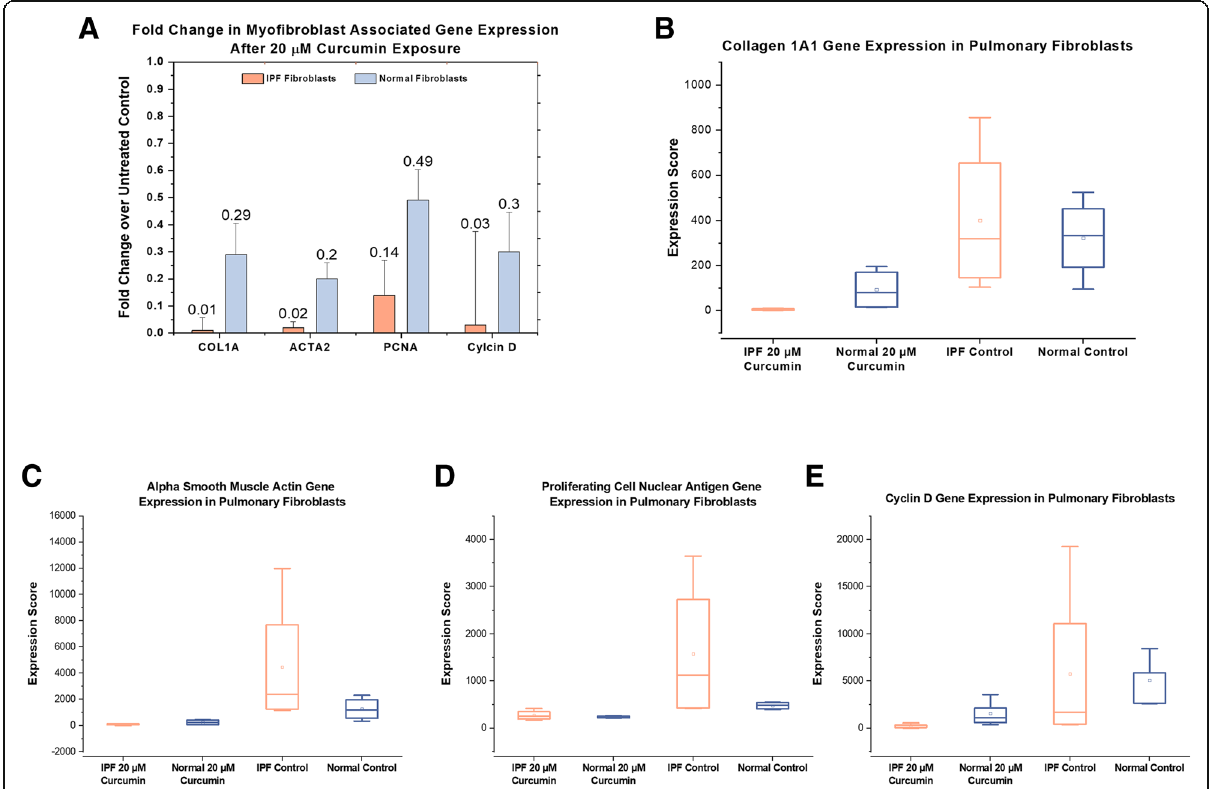
Fig. 1 Curcumin treatment reduces myofibroblast associated gene expression in fibroblasts: ( a ) 24-h 20 μ M curcumin treatment significant ( p < 0.05) reduces gene expression of Collagen 1a1, Smooth Muscle Actin, Proliferating Cell Nuclear Antigen, and Cyclin D in both IPF-F ( n = 4) and NHLF ( n = 3) ( b - e ) Heterogeneity of gene expression before curcumin treatment is observed for all four genes in IPF-F but not in NHLF. Additionally this heterogeneity is absent after 20 μ M curcumin treatment in both cell types. * indicates p value < 0.05 ** indicates p value <